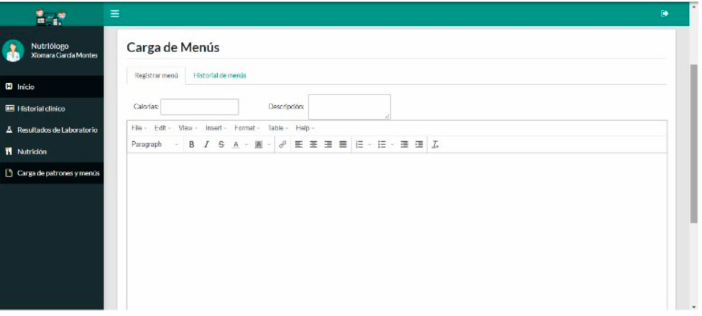
Figure 34. Nutritionist application interface: loading of food menus.